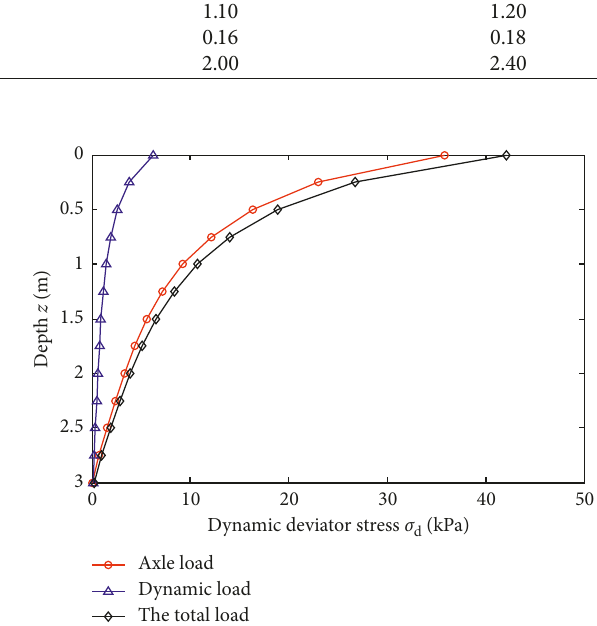
Figure 5: Variations of the dynamic deviator stress σ d caused by